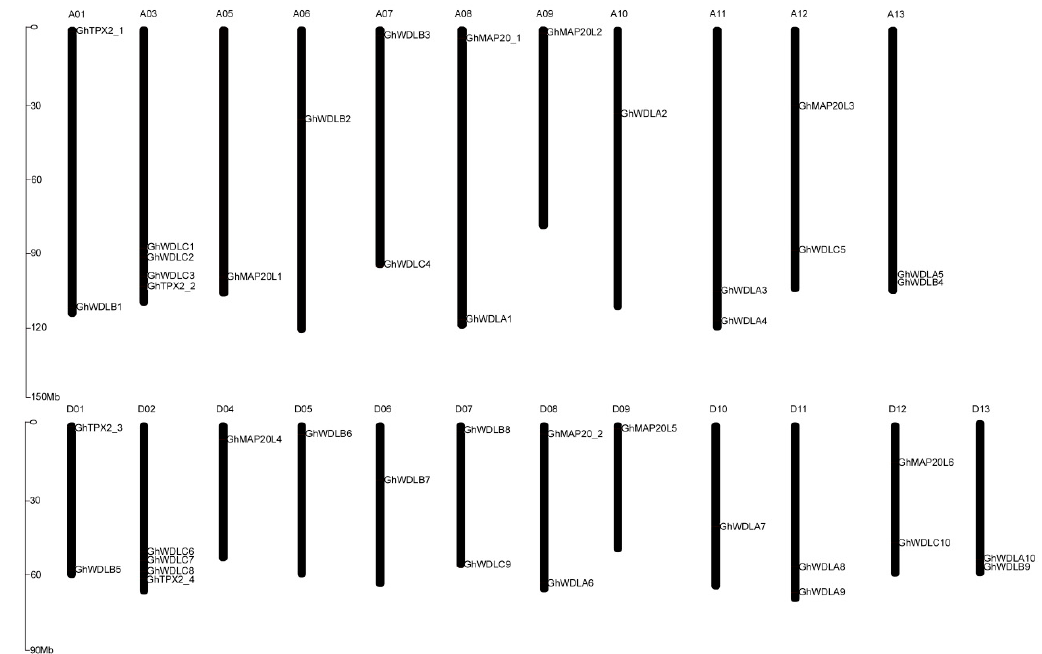
Figure 3. Chromosomal distribution of TPX2 genes in G. hirsutum L.